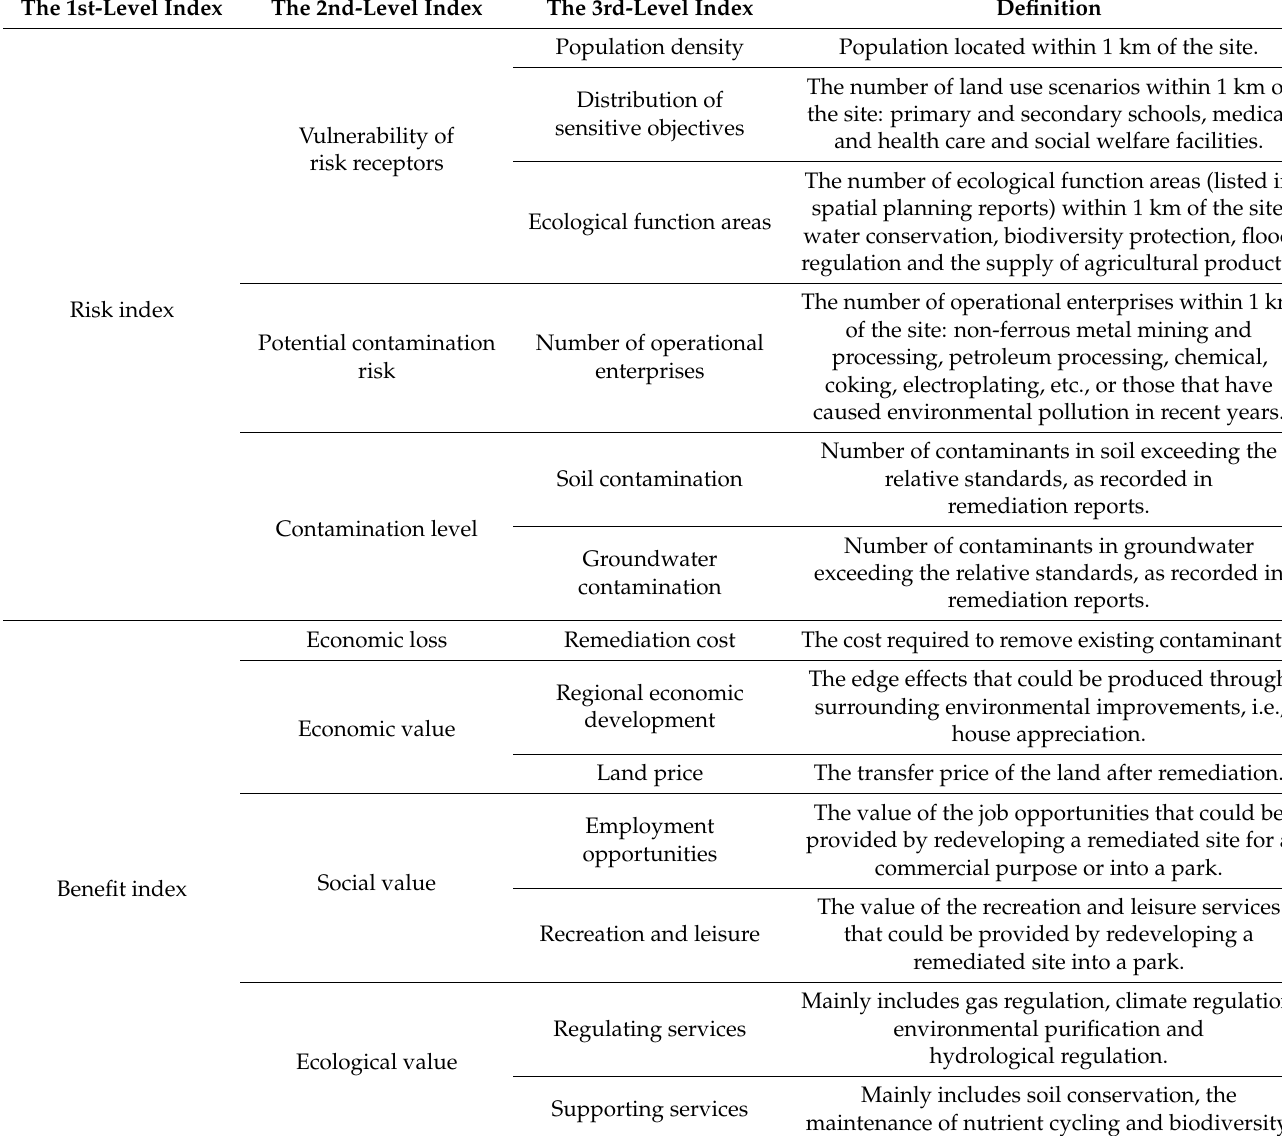
Table 2. Sustainable risk management zoning indicators for contaminated